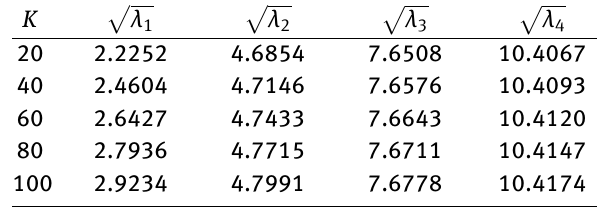
Table 23: Frequency parameter Winkler modulus parameter K